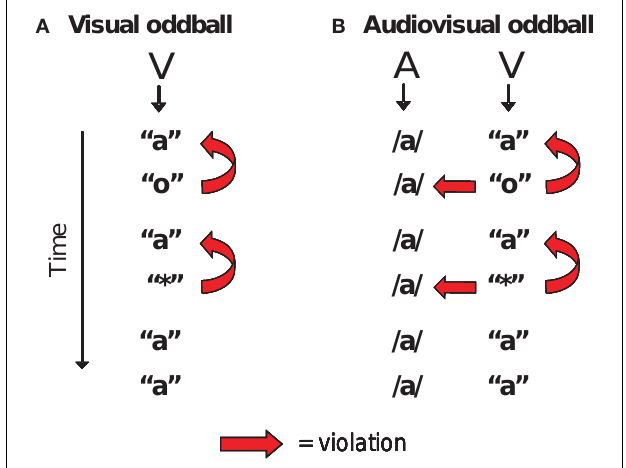
FIGURE 1 | Visualization of the design in the visual (A) and the audiovisual experiment (B). ‘A’ stands for auditory stimulus, ‘V’ stands for visual stimulus. The ‘o’ was the letter deviant violating the previously presented standard letter ‘a’, and in the audiovisual experiment also the simultaneously presented speech sound /a/. The ‘*’ was the non-letter deviant included to control for letter-specifi